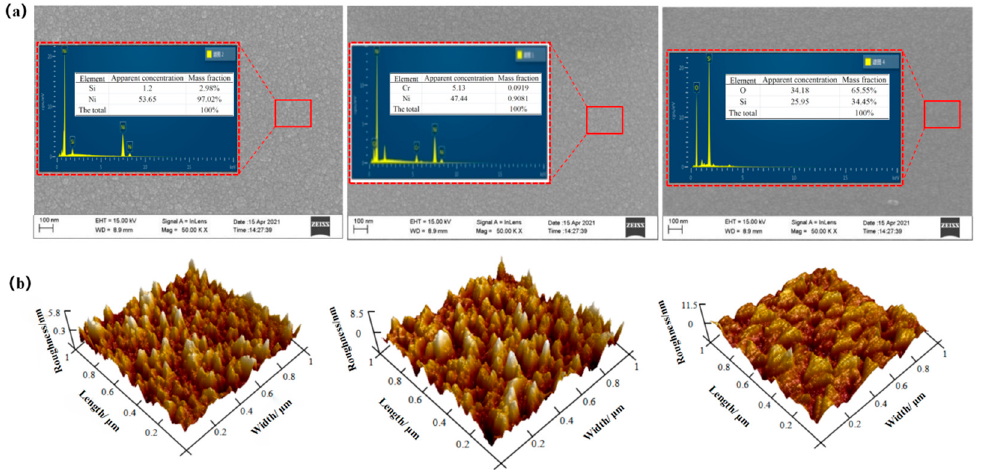
Figure 7. ( a ) Energy spectrum analysis diagram and SEM of the NiCr, NiSi, and SiO 2 films. ( b ) AFM of the NiCr, NiSi, and SiO 2 films.